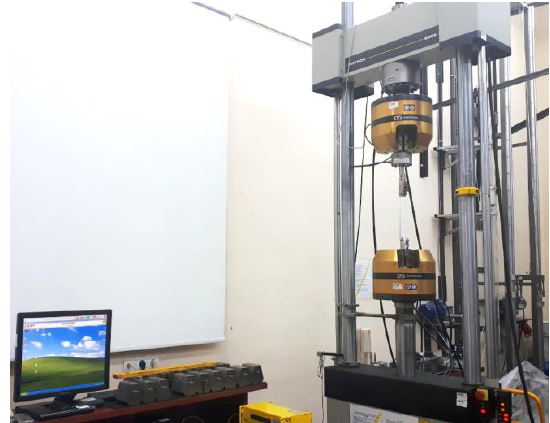
Figure 5. Instron 8802 testing machine for static tests. Table 2. Parameters of Instron 8802 testing machine.